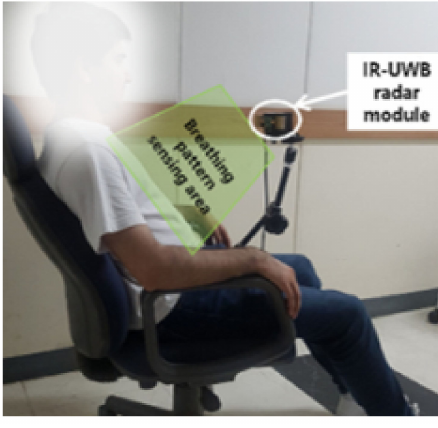
Figure 1. Experimental